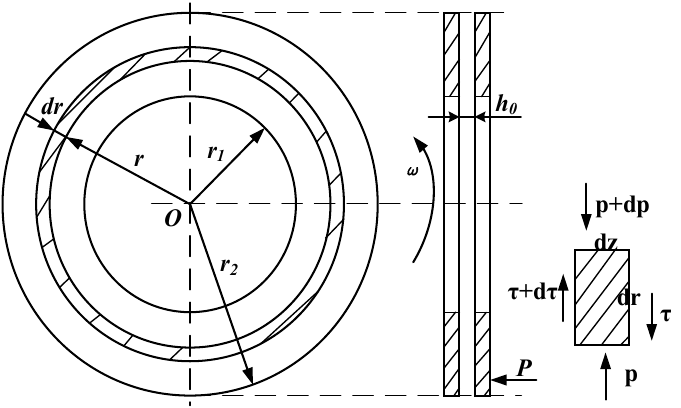
Figure 3. The oil unit force analysis.